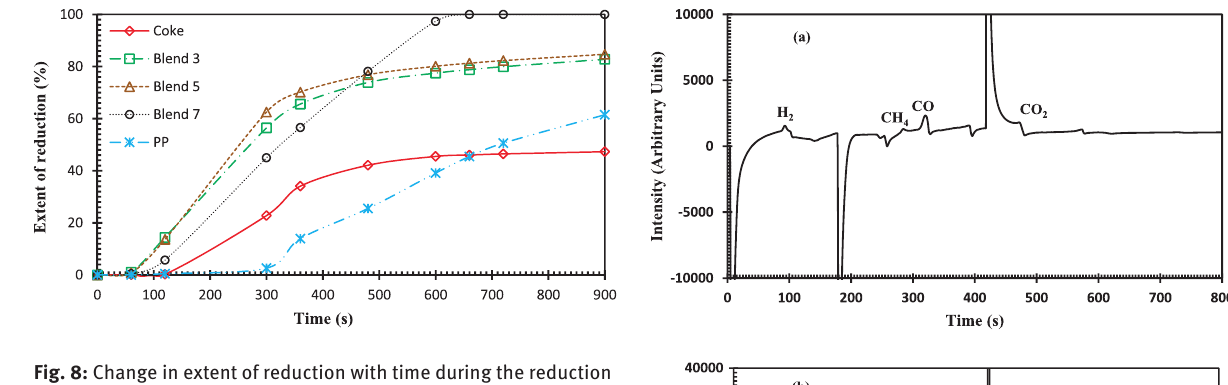
Fig. 8: Change in extent of reduction with time during the reduction of FeO in slag by various reductants at 1500 °C